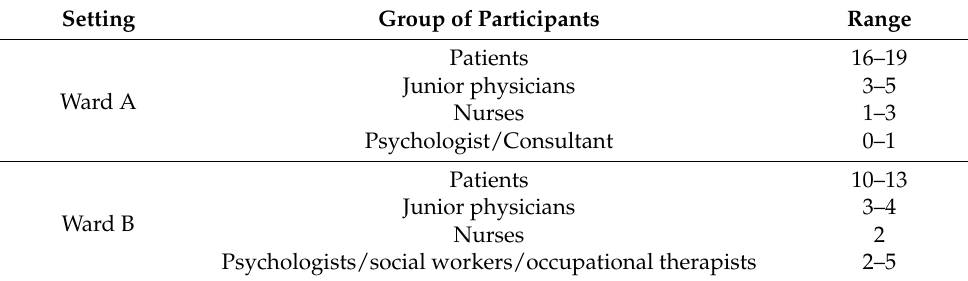
Table 2. Number of participants per observation